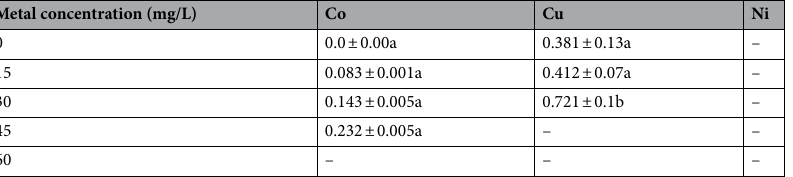
Table 4. Comparison of the average metal content (mg/gDw) of Pleurotus sp . mycelia grown in MMN medium containing heavy metals based on Duncan’s test. Treatments with the same letters are not statistically different.